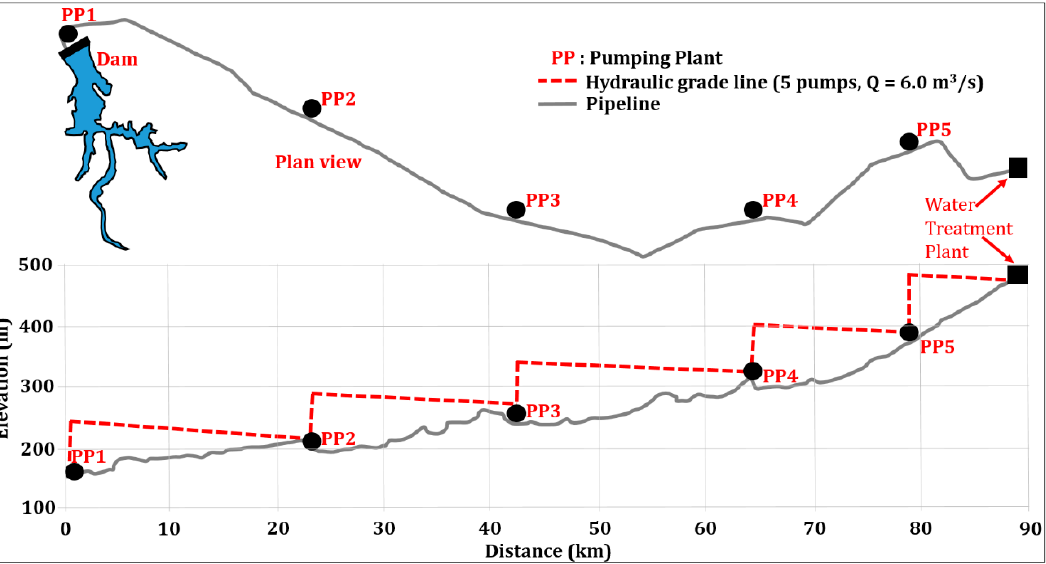
Figure 1. Profile of the pipeline.